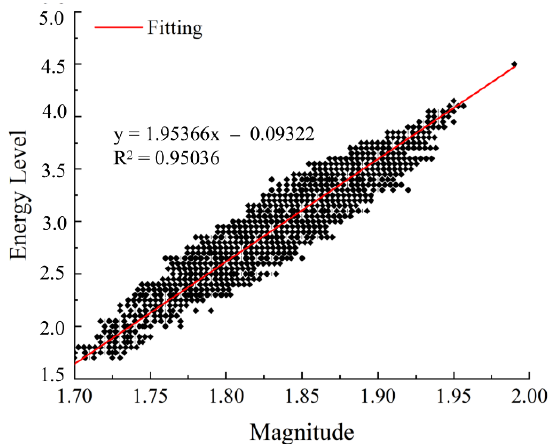
Figure 6. Regression analysis of energy level–magnitude.